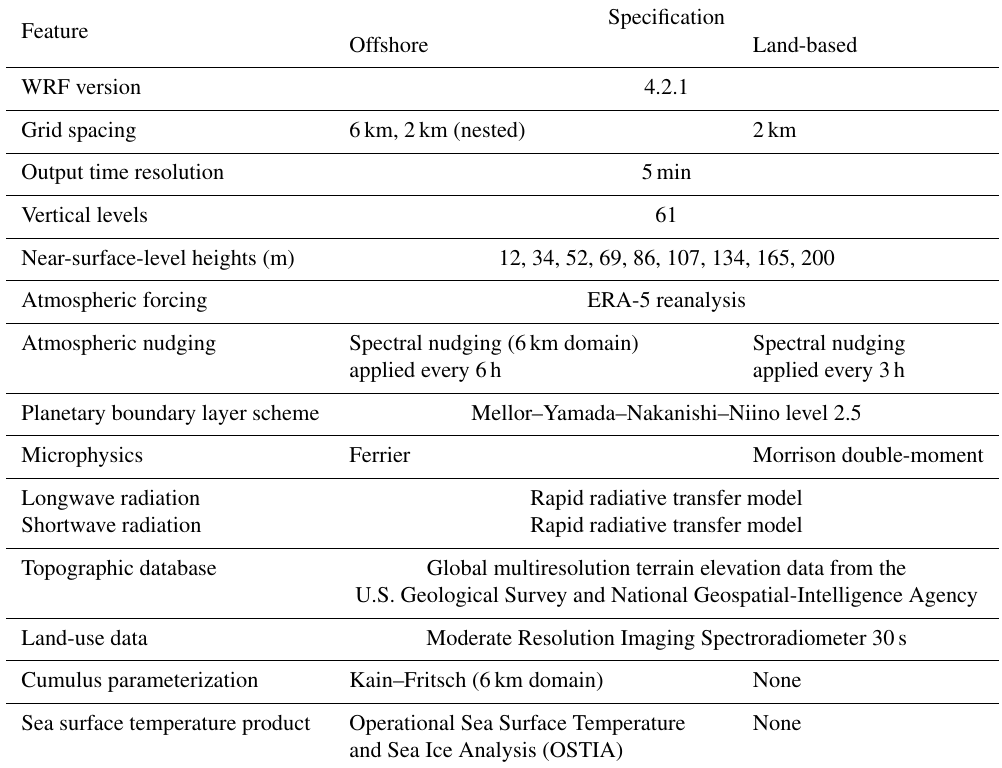
Table 1. Key attributes of the WRF simulations in WTK-LED setup used in this